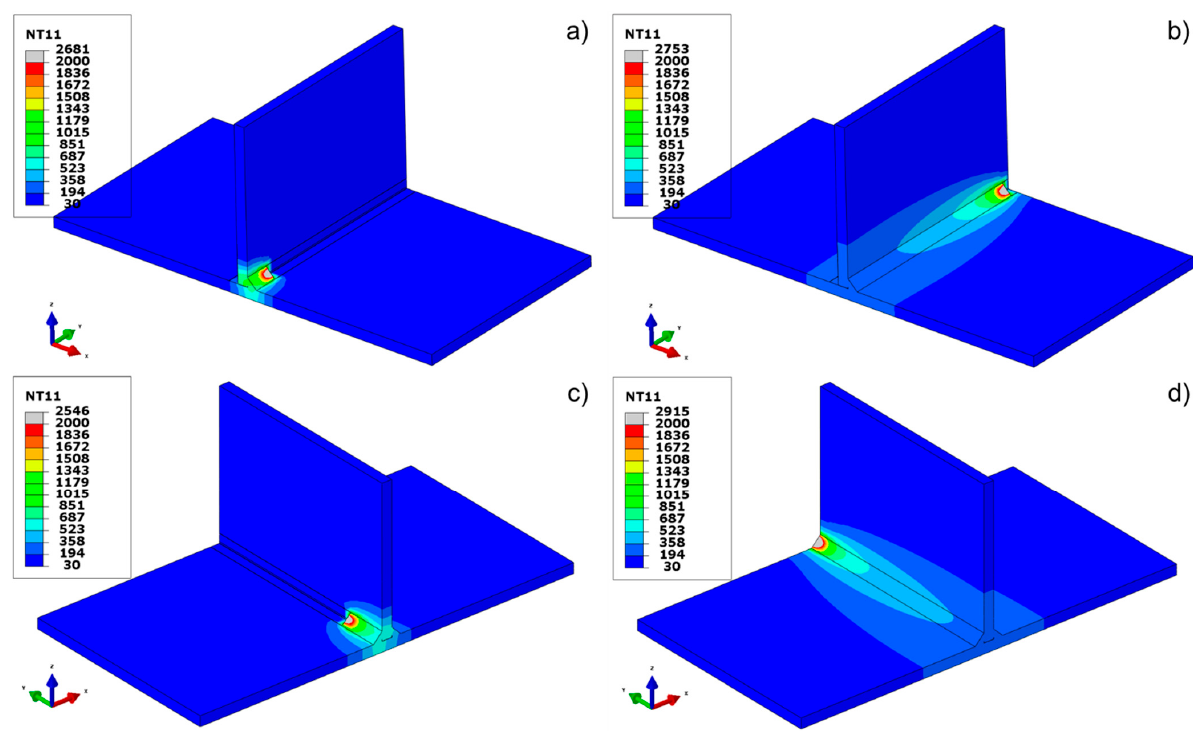
Figure 8. Temperature distributions (°C) during welding at various simulation frames: ( a ) at the beginning of the first pass, ( b ) at the end of the first pass, ( c ) at the beginning of second pass, ( d ) at the end of the second pass.